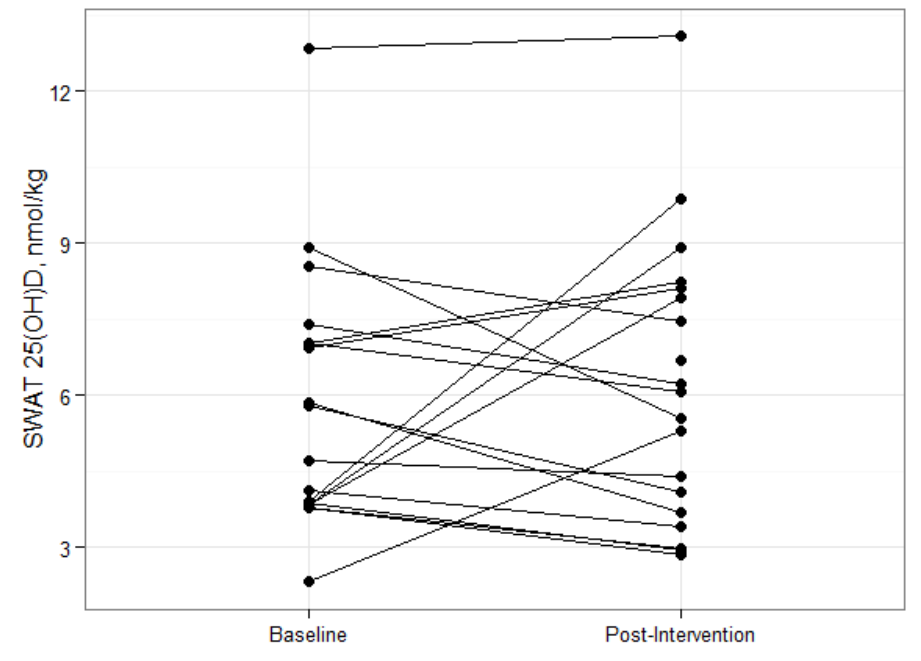
Figure 1. Individual changes in Subcutaneous White Adipose Tissue 25(OH)D concentrations from Baseline to Post-Intervention in adults who participated in a 15 week weight loss trial. n = 18 (Baseline) and 19 (Post-Intervention).